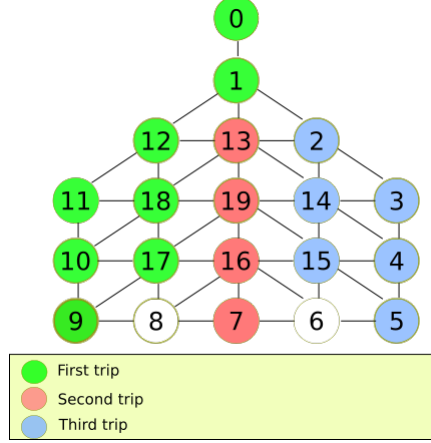
Figure 8. The best way to explore a graph with the required number of steps is by having each trip visits both a line and its adjacent line. Since there are p h lines, that is the minimum number of trips to explore the whole graph. In this particular example, p h is equal to five.